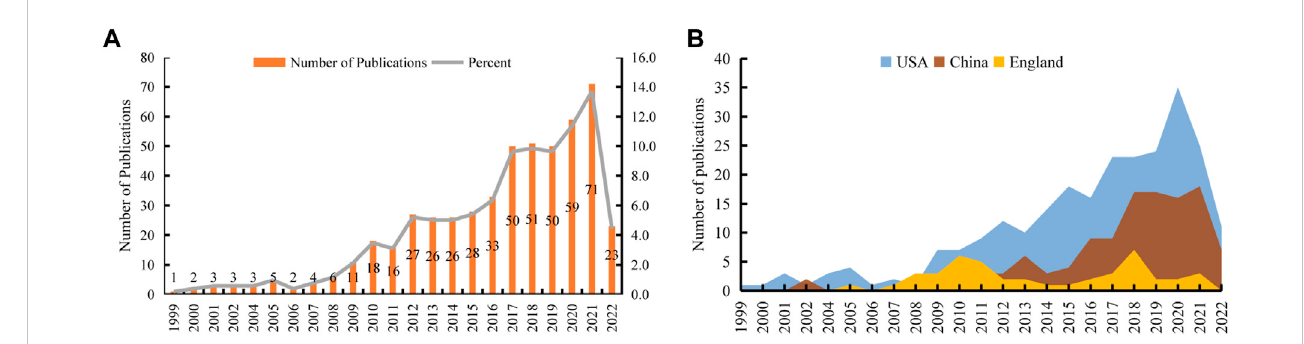
FIGURE 2 Thenumberofpublicationsrelatedto theapplicationofstemcells forglaucomatreatment andresearch. (A) Thenumberofpapers publishedeach year. (B) The top three countries/regions ’ annual publications.